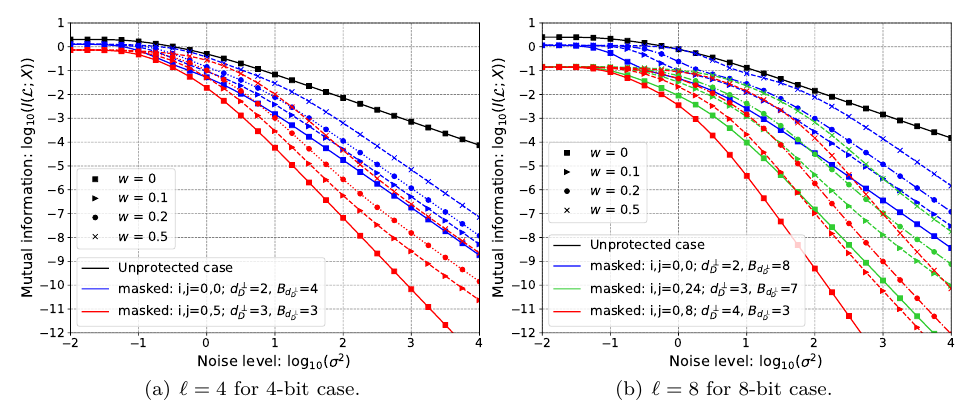
Figure 5: The intra-share independence issue: the existence of higher-order leakages decreases the security of the corresponding masking scheme (two public parameters are α 1 = α i , α 2 = α j as in Tab. 1). Note that the blue curves are for the Boolean